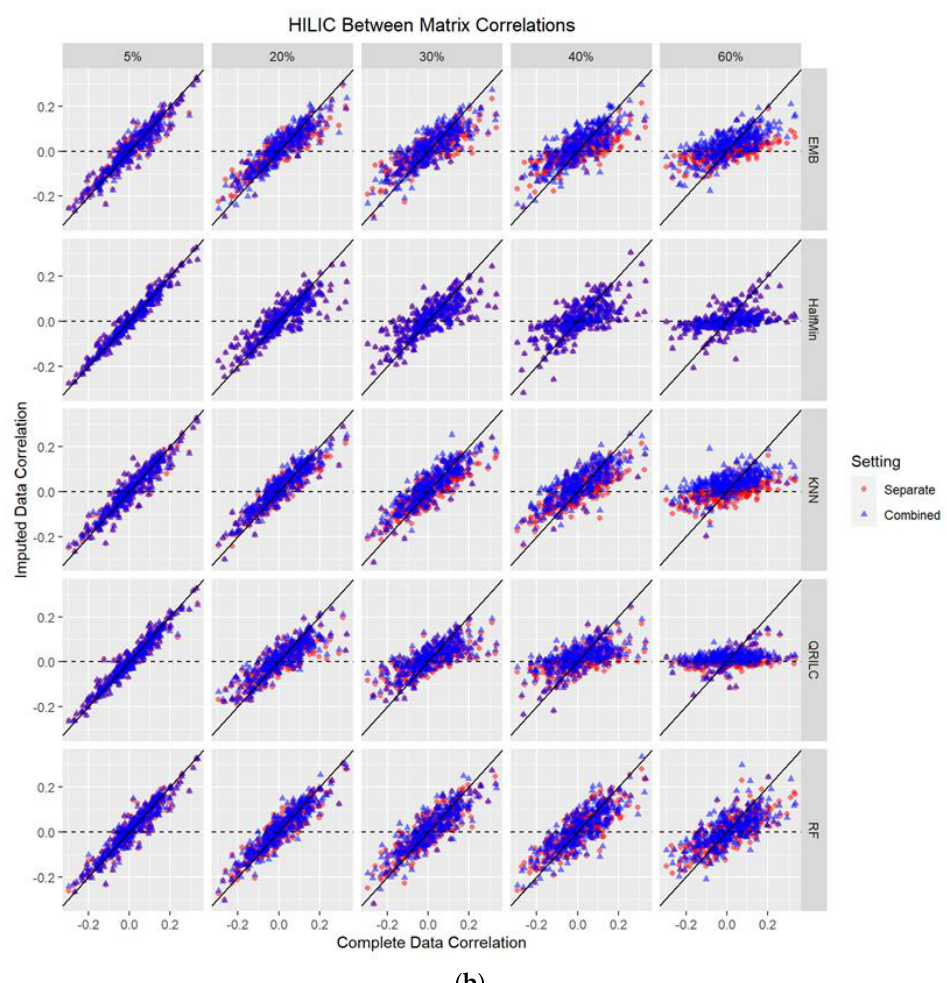
Figure 2. ( a , b ): Scatterplots of between-biospecimen correlations of the true complete data against those of the imputed data (at 5%, 20%, 30%, 40%, 60% missing values imputed) for GCTOF data set. Each dot represents an individual metabolite. EMB = Estimation/Maximization with Bootstrap imputation. Half Min = Half the Minimum observed value imputation. KNN = k Nearest Neighbors imputation. QRILC = Quantile Regression Imputation Left Censored data. RF = Random Forest imputation. ( b ) Scatterplots of between-biospecimen correlations of the true data against those of imputed data (at 5%, 20%, 30%, 40%, 60% missing values imputed) for the HILIC data set. Each dot represents an individual metabolite. EMB = Estimation/Maximization with Bootstrap imputation. Half Min = Half the Minimum observed value imputation. KNN = k Nearest Neighbors imputation. QRILC = Quantile Regression Imputation Left Censored data. RF = Random Forest